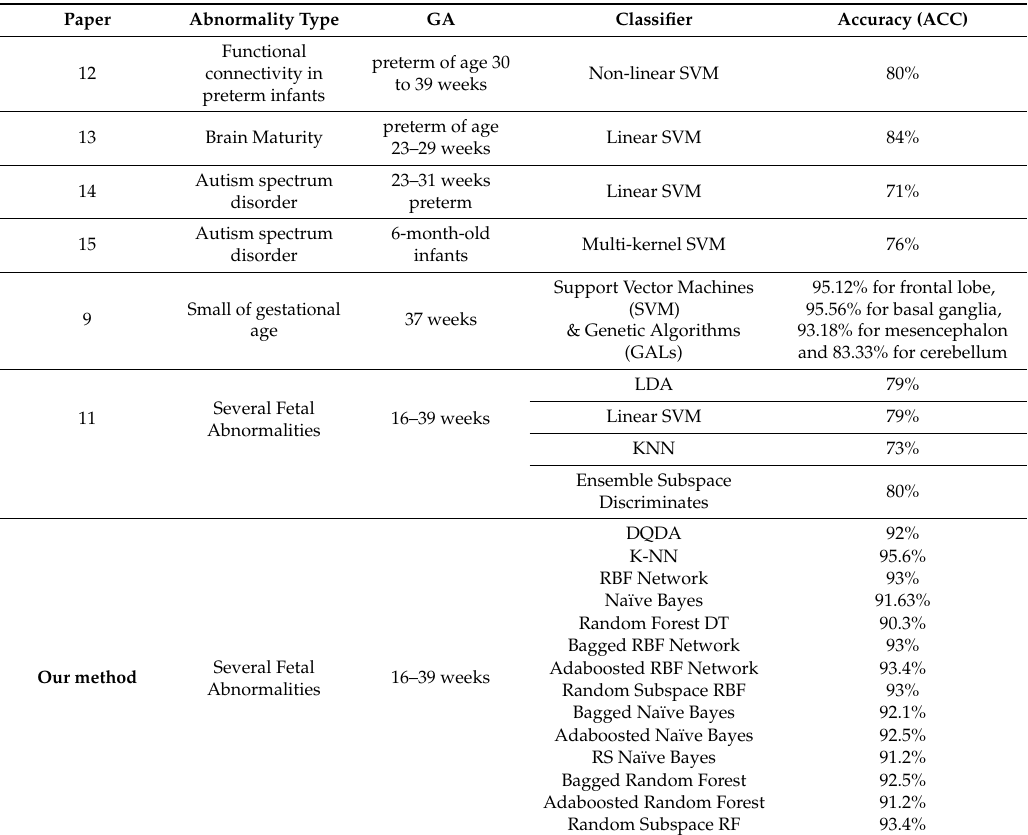
Table 8. Comparisons between the performances of our novel presented approach and recent related approaches for preterm, neonates, and